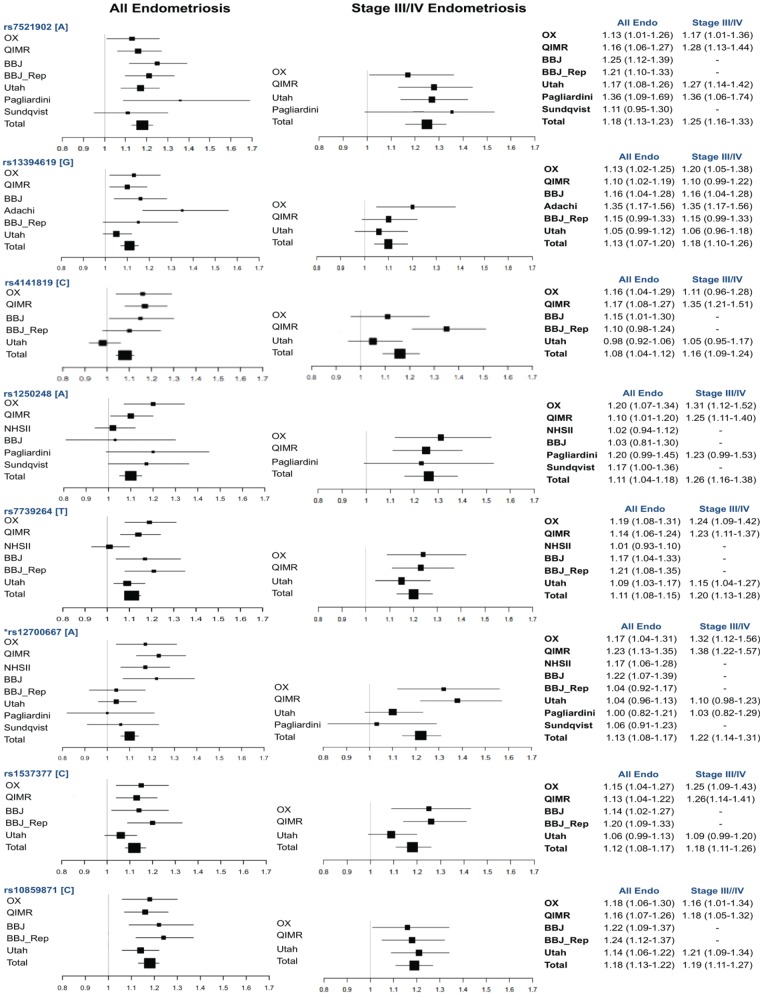
Forest plots showing the effects of risk alleles for SNPs in six loci reaching genome-wide significance for association with all endometriosis and two loci reaching borderline genome-wide significance with only Stage III/IV cases in the meta-analysis. BBJ_Rep, BioBank Japan replication.